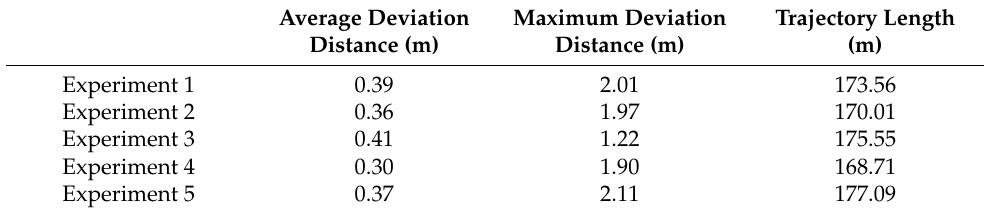
Table 2. Five groups of experiments after improvement.